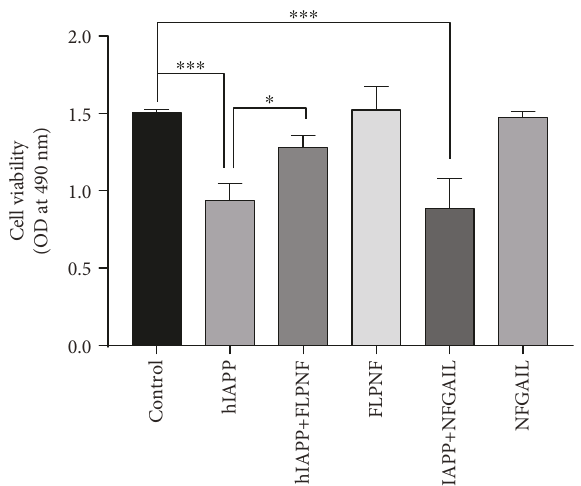
Figure 6: Inhibition of hIAPP cytotoxicity in INS-1 cells by adding FLPNF or NFGAIL. The cell viability was measured by the MTS assay. “ Control ” means INS-1 cells incubated in medium alone. The concentration of hIAPP added was 10 μ M, while the concentrations of FLPNF and NFGAIL were 100 μ M (the OD values read at 490nm were presented as means ± SD ; each experiment was repeated thrice; unpaired t -test, ∗∗∗ P < 0 001 ; ∗ P < 0 05